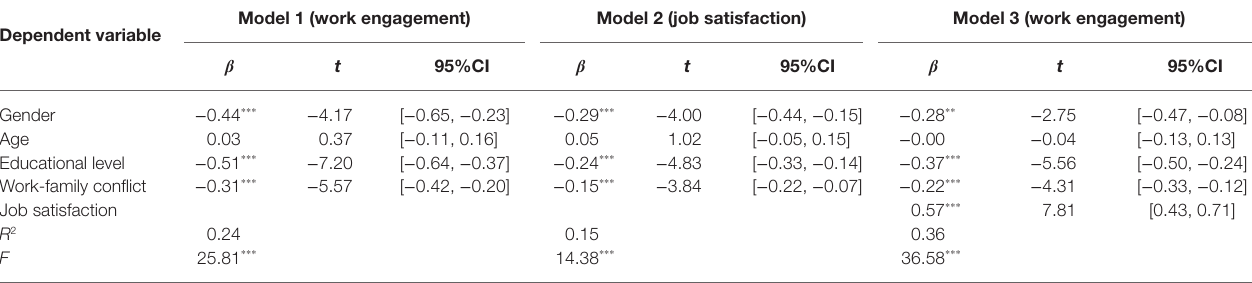
TABLE 3 | Mediating effect of job satisfaction in the relationship between work-family conflict and work engagement.